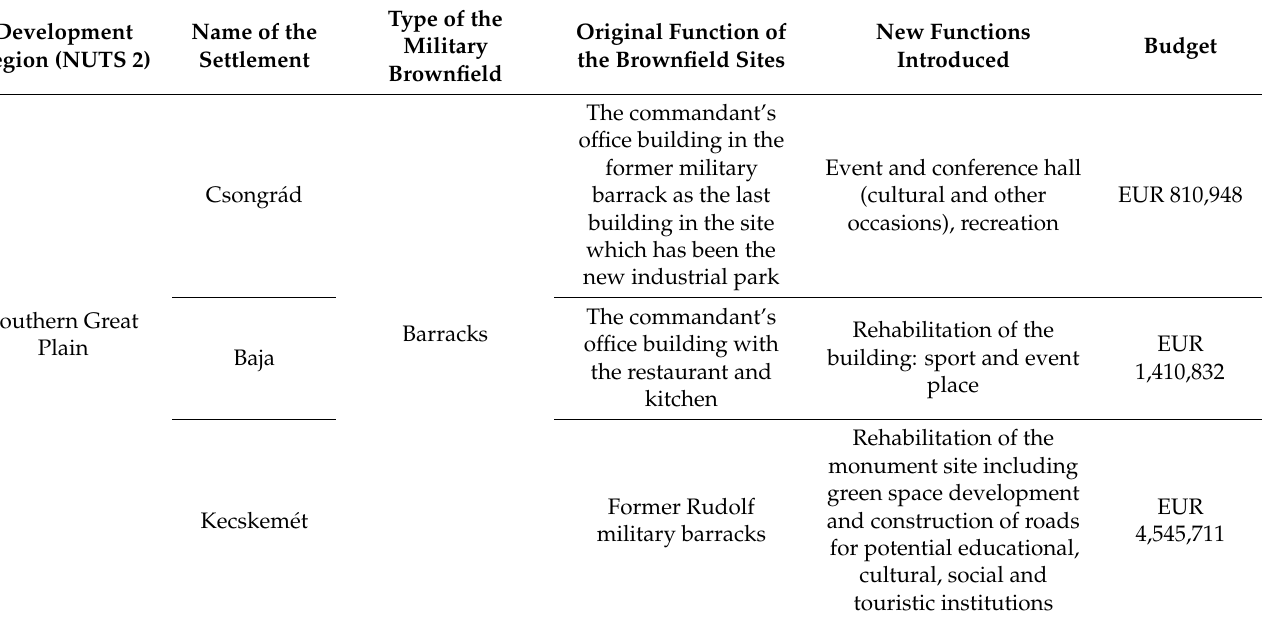
Table 7. Redevelopment projects for military brownfields.